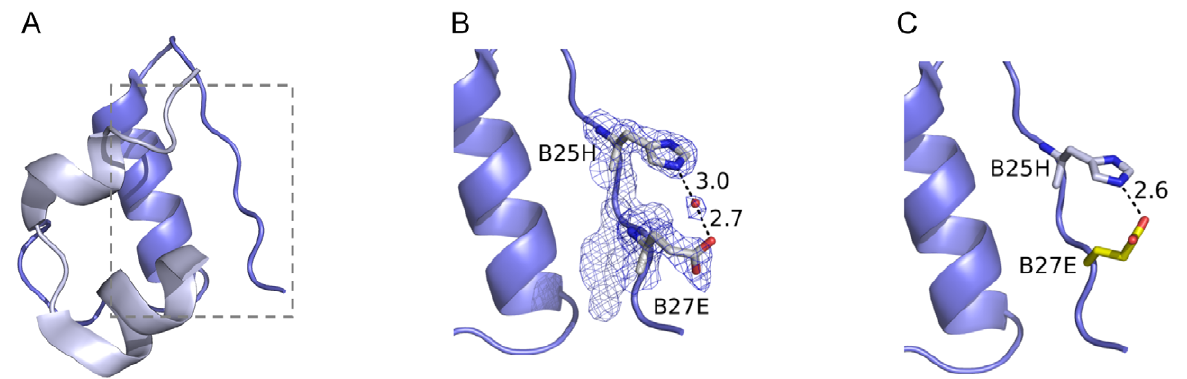
Figure 2. Structure of the [B25H, B27E] insulin analogue. ( A ) Overview of the [B25H, B27E] insulin analogue with the A chain and B chain depicted in light- and dark blue, respectively. The segment shown in panel B and C is indicated by a gray dotted line in A. In ( B ), the 2Fo-Fc electron density is shown for residues B25H to B27E contoured at 1 s . A hydrogen bond interaction is mediated by a water molecule (red sphere), but no direct interaction is shown between B25H and B27E. In ( C ), a modelled B27E residue is shown (yellow) in another rotamer orientation to indicate that a direct interaction between B25H and B27E could be possible. Distances are shown in A˚ngstrom.